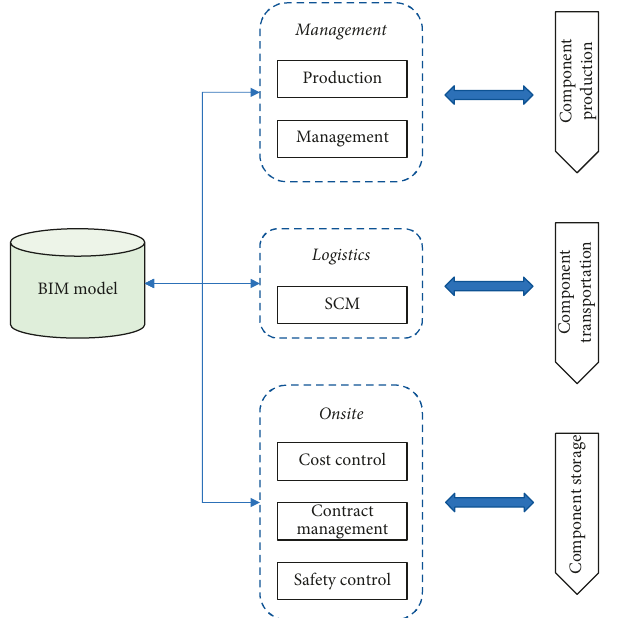
Figure 8: Process of BIM